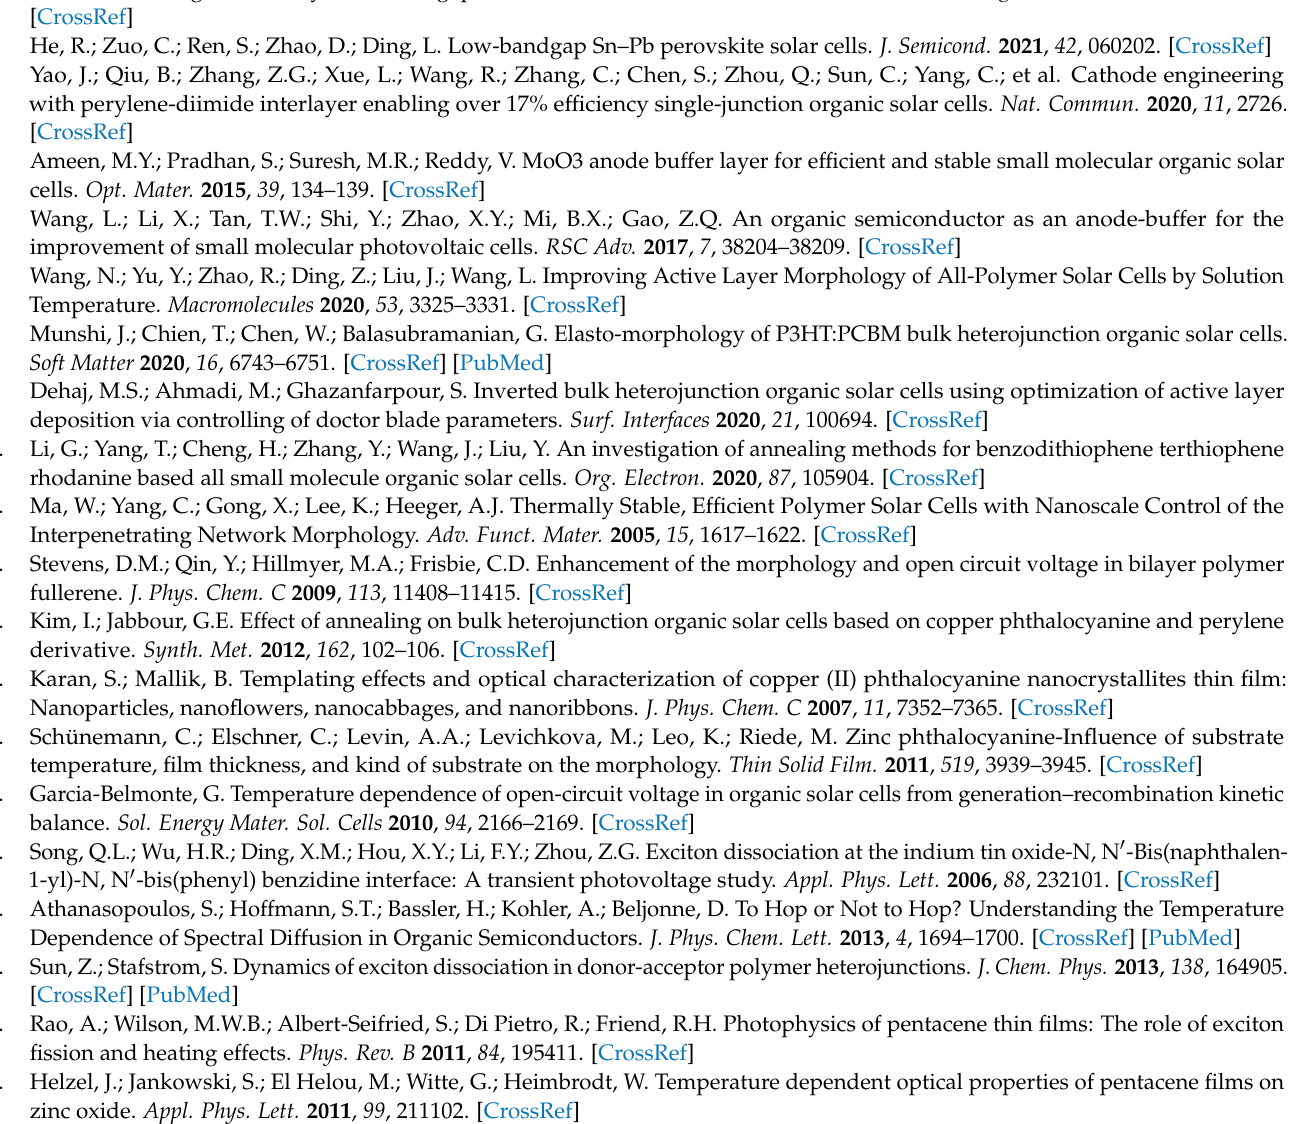
lengths. Figure S2: (a) Absorption spectra for a 50 nm CuPc thin film thermal evaporated on quartz substrate and (b) the relative changes of absorption efficiency. Figure S3: Absorption ratio with 77 K and 300